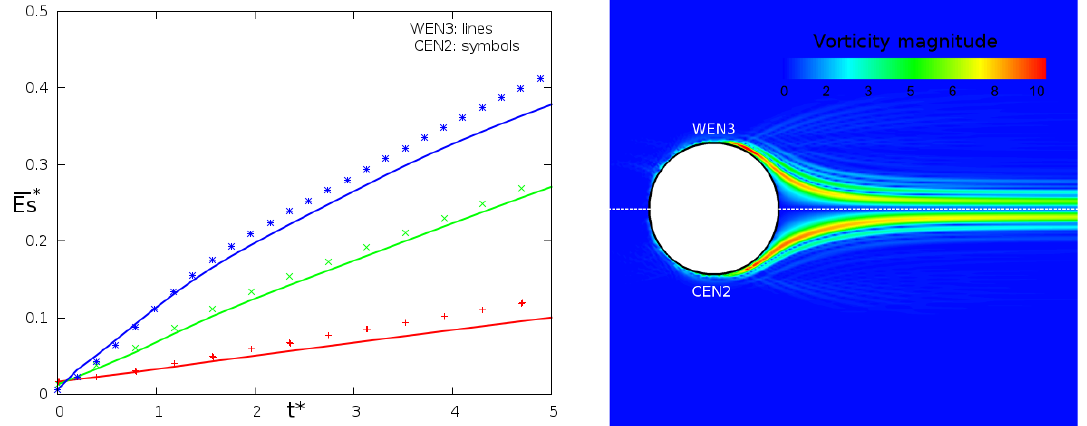
Figure B2. Solving the Euler equations: (a) influence of the space resolution (red: MESH1; green: MESH2; blue: MESH3) on the vorticity ∗ ∗ ) when the near-interface advection is modeled by WEN3 (line) and CEN2 + ν ref production E s (t obtained by WEN3 (top) and CEN2 + ν ref art